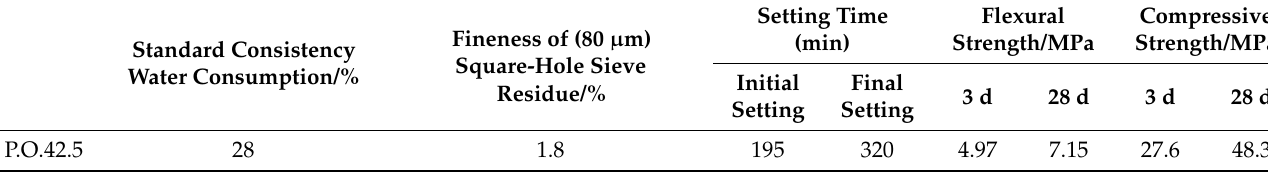
Table 1. Physical properties of cement.